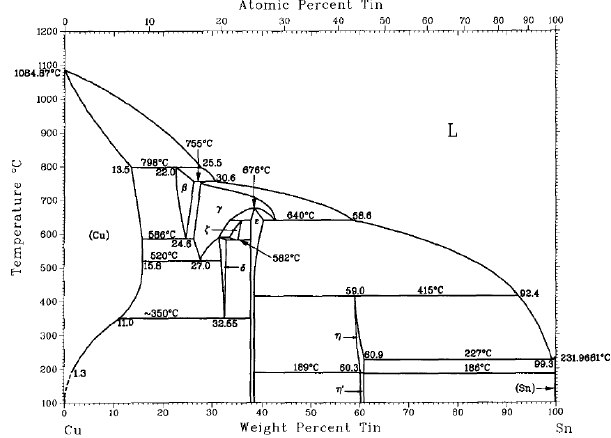
Figure 1. Phase diagram of the binary CuSn alloy [12]. Reproduced with permission from Bulletin of Alloy Phase Diagrams, Springer Nature, 1990.